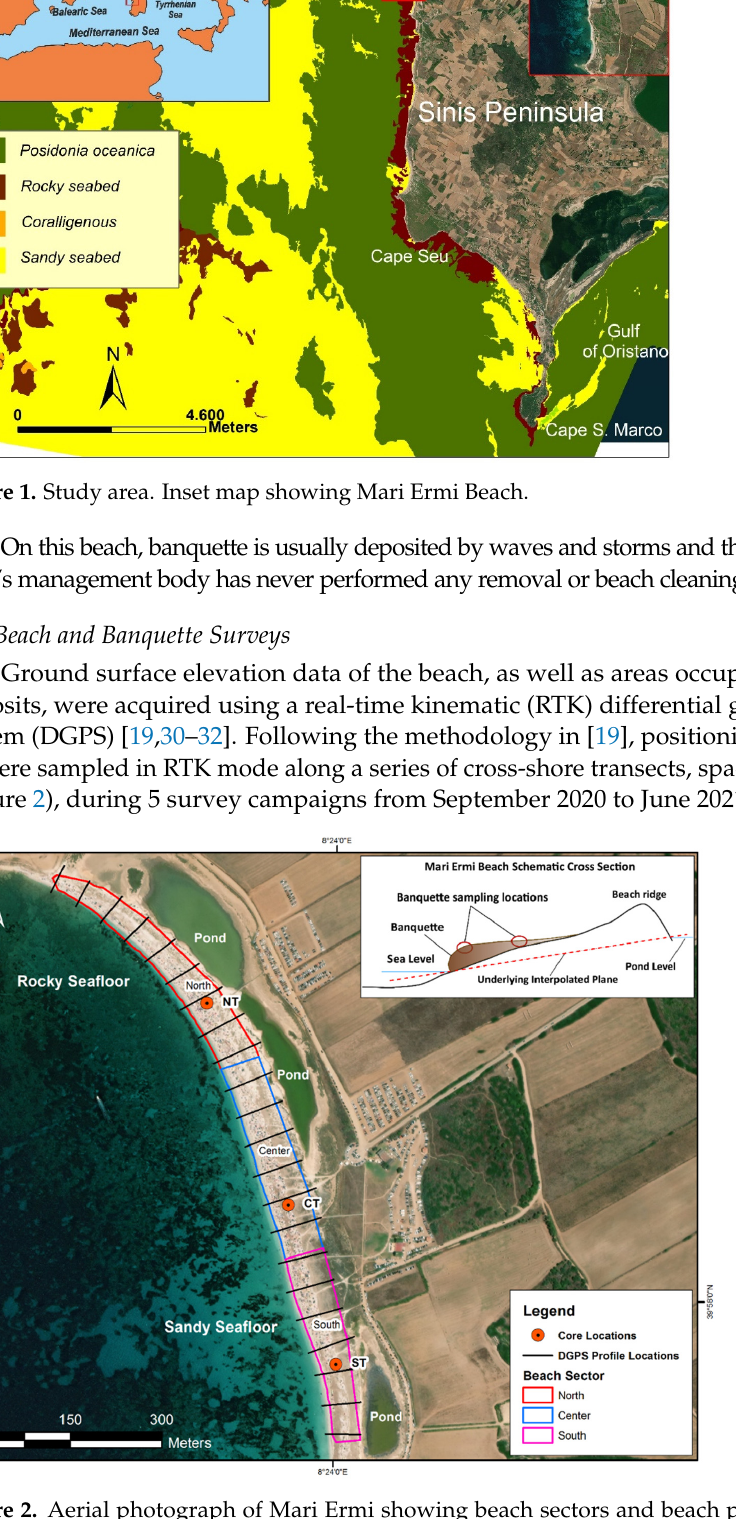
Figure 2. Aerial photograph of Mari Ermi showing beach sectors and beach profile locations. Inset figure shows schematic beach sections with banquette sampling locations and the underlying inter- polated beach